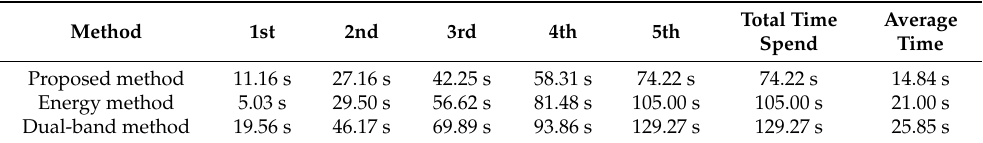
Table 5. The completion time of each plate measurement, the total time spend of each measurement, and the average measurement time of each